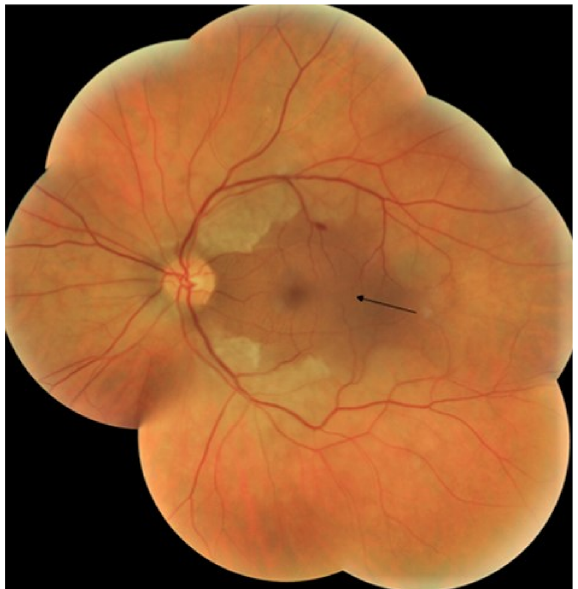
Figure 1. Baseline composite fundus photograph of the left eye showing retinal whitening except for the cilioretinal artery distribution area (black